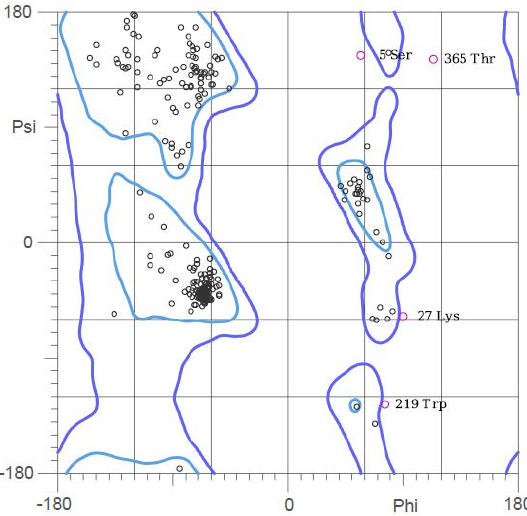
Figure 8. Ramachandran plot of refined multi-epitope vaccine.